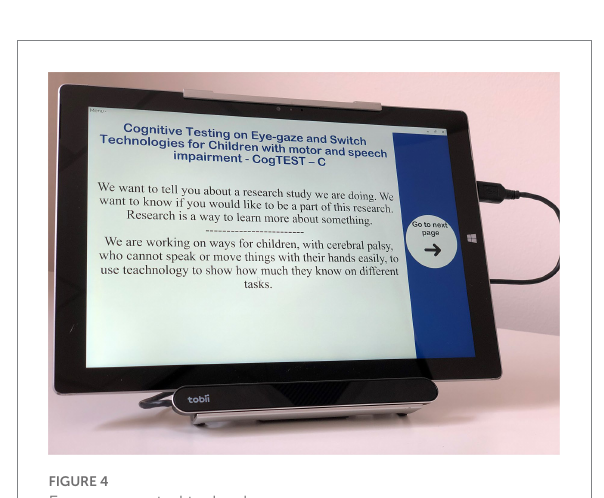
FIGURE 3 Switch